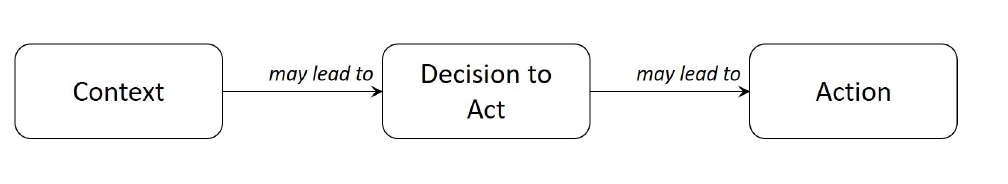
Figure 1. Schematic representation of the Theory of Planned Behavior